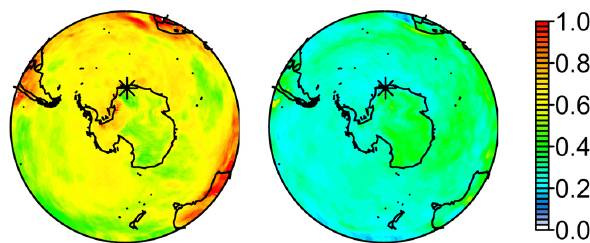
Fig. 4. Scatter plot of the aerosol scattering coefficient measured directly by integrating nephelometer (x-axis), and calculated from the particle number size distribution assuming non-absorbing, spherical particles consisting of ammonium sulphate, one panel for each of the nephelometer wavelengths. Also plotted are the linear regression lines (red solid, intercept fixed at 0), including their slope m and the coefficient of determination R 2 , as well as the 1 : 1 line (black dashed).